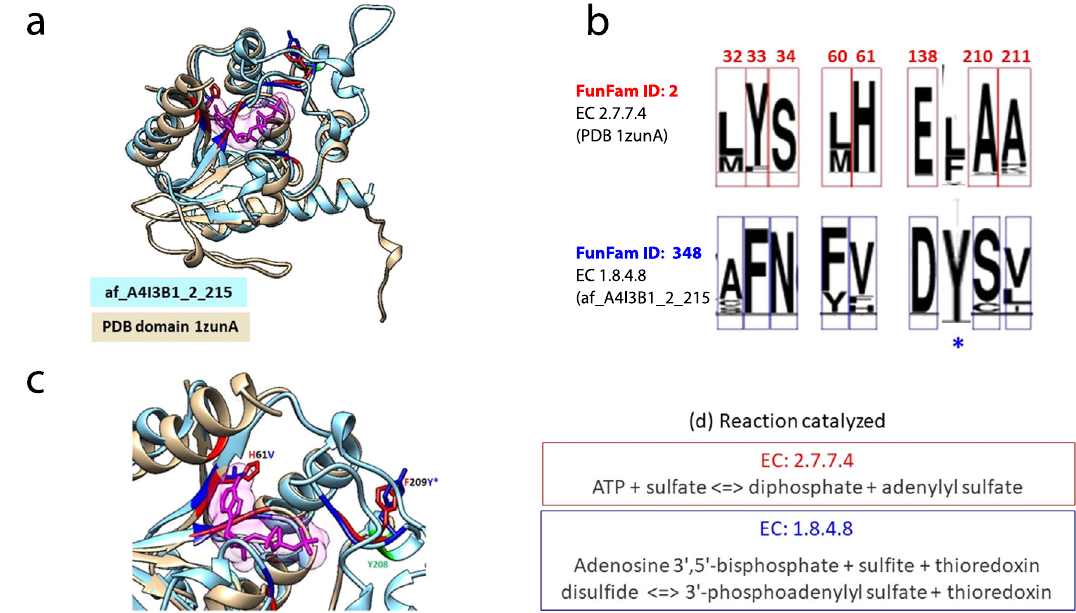
Fig. 6 Functional diversity between protein families revealed using Alphafold2: The HUP superfamily as an example. Members of HUP superfamily (CATH ID:3.40.50.620) possess a common structural core comprising a Rossmann αβα -sandwich fold. Several functional families within the HUP superfamily lacking a representative PDB structure now possess a representative domain from Alphafold2 enabling characterisation of putative functional sites in their associated functional families. For example, the Phosphoadenosine phosphosulfate reductase-like protein family (PPR) (CATH FunFam ID: FunFam-348; EC: 1.8.4.8) has a high-quality AF2 domain available for the poorly studied PPR protein from L eishmania infantum (af_A4I3B1_2_215; pLDDT: 94.87). This protein has no close homologue in the PDB (>30% sequence identity). We compared the AF2 model with the representative PDB structure (1zunA) from its closest Functional Family in CATH i.e., Sulphate adenylyltransferase family (SAT) [FunFam-02, representative PDB:1zunA; EC:2.7.7.4]. a Superposition of structure representatives from FunFam-348-PPR and FunFam-02-SAT. Residues conserved in both families are coloured green, FunFam- speci fi c residues, blue (af_A4I3B1_2_215, for FunFam-348-PPR) and red (1zunA, for FunFam-02-SAT). b FunFam-2-SAT is involved in ATP hydrolysis, an essential process for its function. Analysis of conserved residues using Scorecons indicated that most active site residues (shown in red) are conserved differently between the two functional families. Moreover, there is a change in catalytic residue site (indicated as blue *) in PPR i.e., F(/L)209Y. The height of each residue indicates its degree of conservation. c Close-up view of differentially conserved positions between the families in the active site FunFam- 02-SAT (red) and FunFam-348-PPR (blue). The substrate molecule (AGS) in FunFam-02-SAT (1zunA) is shown in magenta. Chemically different residues highlighted in the substrate-binding site (H61V) and catalytic site (F174Y) of FunFam-348. d Catalytic mechanisms for the two Enzyme